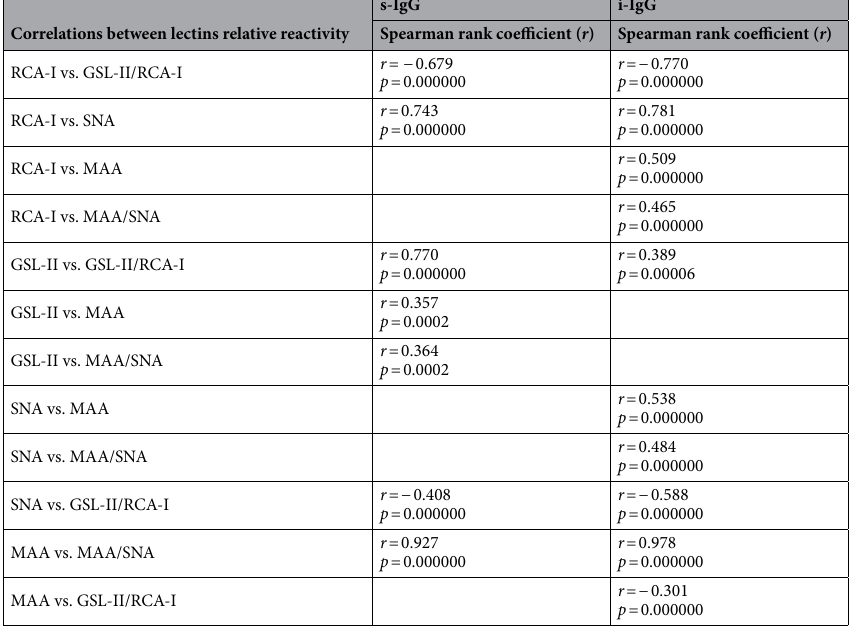
clinical value); SNA 0.364, 0.842 (AUC 0.575—limited clinical value); MAA/SNA 0.659, 0.895 (AUC 0.762— moderate clinical value); RCA-I 0.864, 0.474 (AUC 0.699—limited clinical value); GSL-II 0.866, 0.474 (AUC